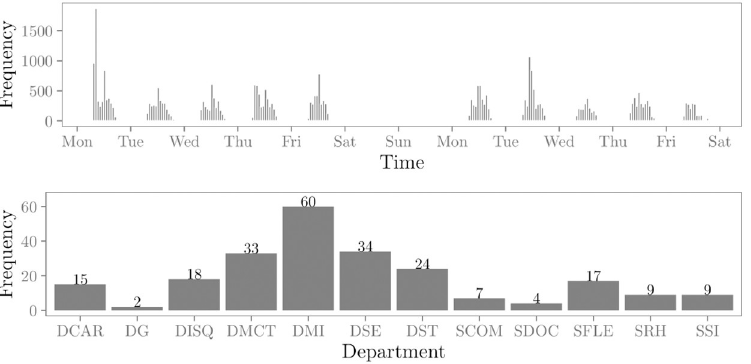
Fig 8. Descriptive information of the empirical data. The top panel shows the frequency distribution of the events in the relational event sequence over time. The bottom panel shows the frequency distribution of the employees over the